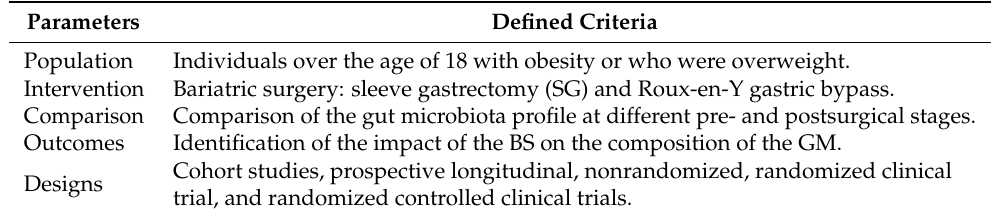
Table 1. Aspects of interest for the initial selection of articles.